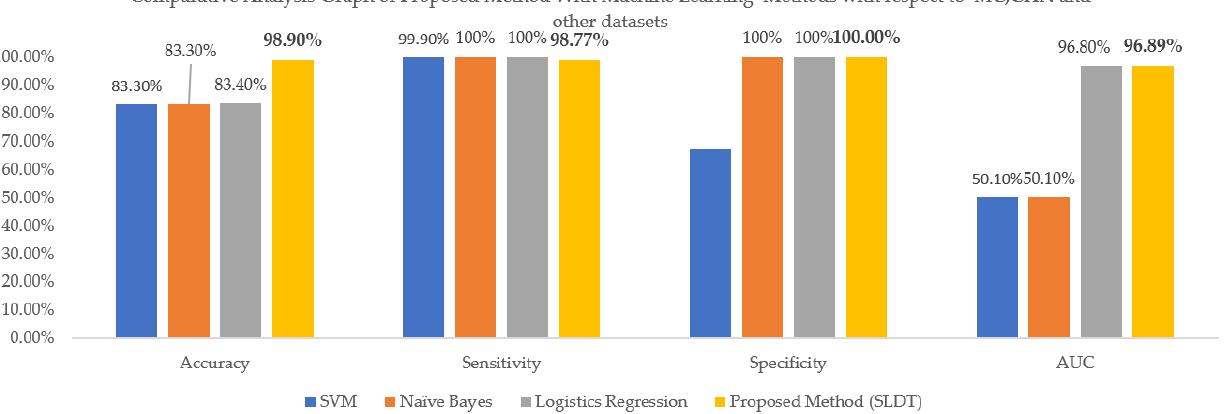
Figure 14. Comparative analysis graph of the proposed method with the machine learning methods with respect to the combined dataset 2 (NLM, Belarus, and RSNA).